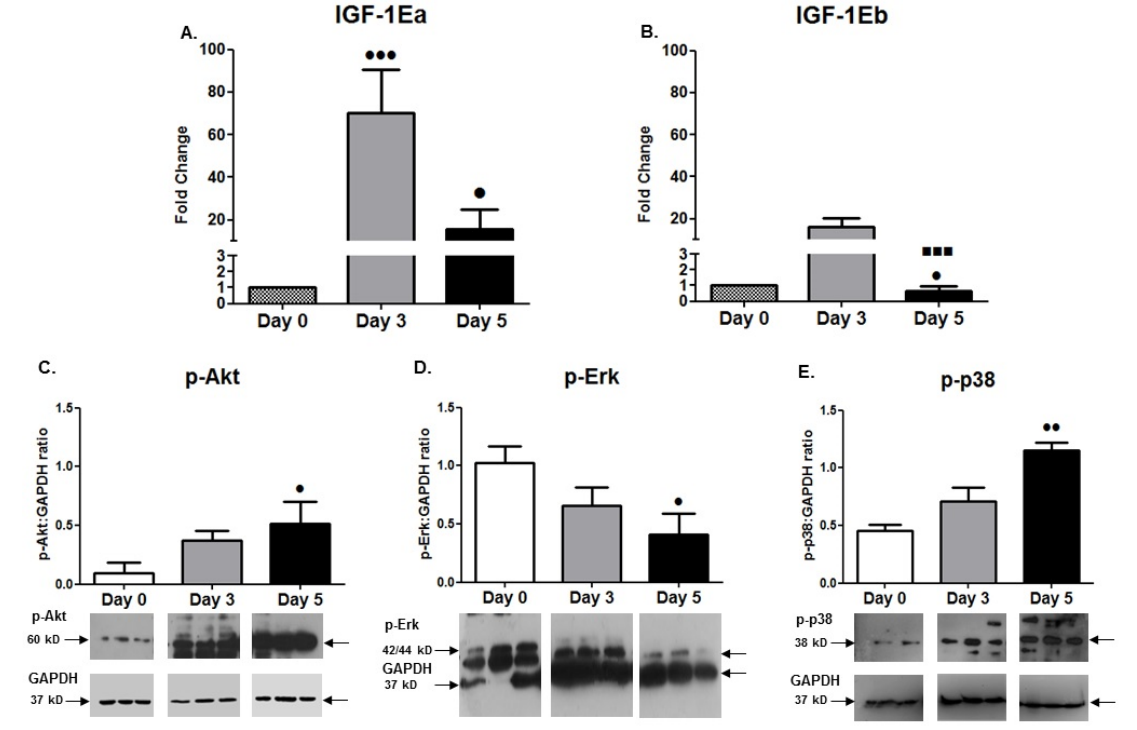
Figure 2. ( Α , B ) IGF-1 isoforms’ expression during cardiomyoblasts differentiation. Quantitative Figure 2. ( A , B ) IGF-1 isoforms’ expression during cardiomyoblasts differentiation. analysis of IGF-1Ea and IGF-1Eb mRNA expression in cardiomyoblasts during their differentiation. ( C – E ) Alterations in the activation of the signalling proteins Akt, Erk1/2, and p38. Representative Western blots and immunoblotting quantification of p-Akt, p-Erk1/2, and p-p38phosphorylation in cardiomyoblasts during their differentiation process. The values of the phosphorylated proteins were normalized to each corresponding GAPDH on the same immunoblot. Significantly different compared to day 0, • p < 0.05; •• p < 0.01; ••• p < 0.001. Significantly different compared to day 3, ▪▪▪ p < 0.001. Mean + SE of three independent experiments performed in triplicate.